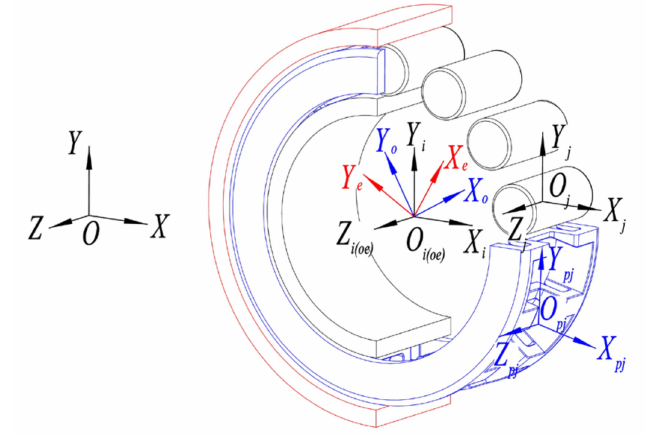
Figure 8. The coordinate system for needle roller